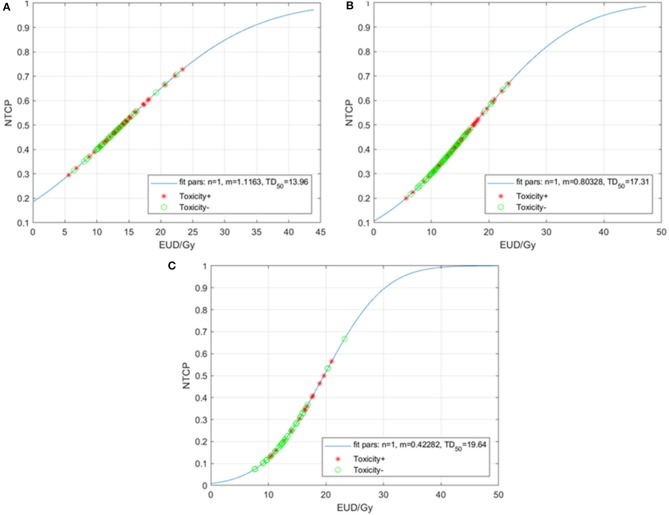
Normal tissue complication probability (NTCP) for acute grade ≥3 hematologic toxicities (HT3+) per the Lyman-Kutcher Burman model with n fixed (n = 1) for all patients (A), patients treated with carboplatin/paclitaxel (B), and those treated with other systemic therapy regimens (C). Patients that experienced HT3+ during chemoradiation are represented by red asterisks; patients without HT3+ are represented by green circles. EUD, equivalent uniform dose.